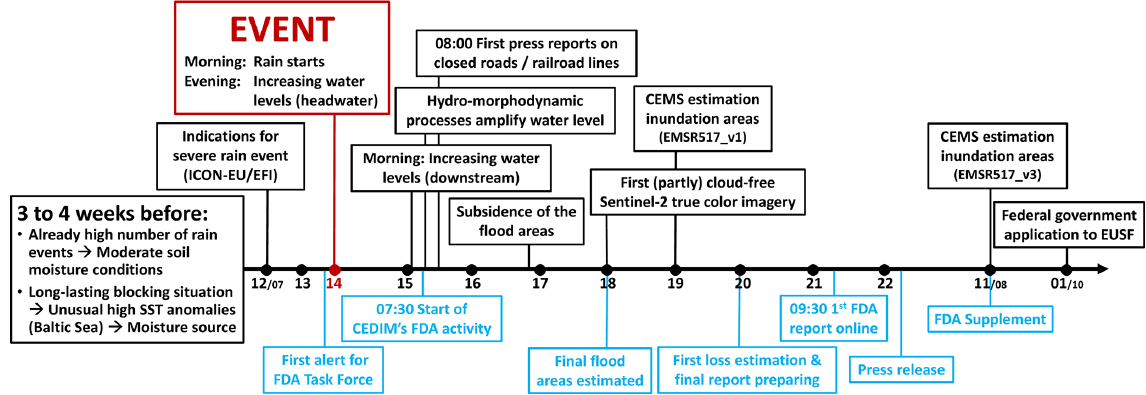
Figure 12. Timeline (hours in UTC) of various relevant processes and activities before, during, and after the July 2021 flood starting on 14 July (dark red). Blue colors indicate activities within the FDA task force. More details see